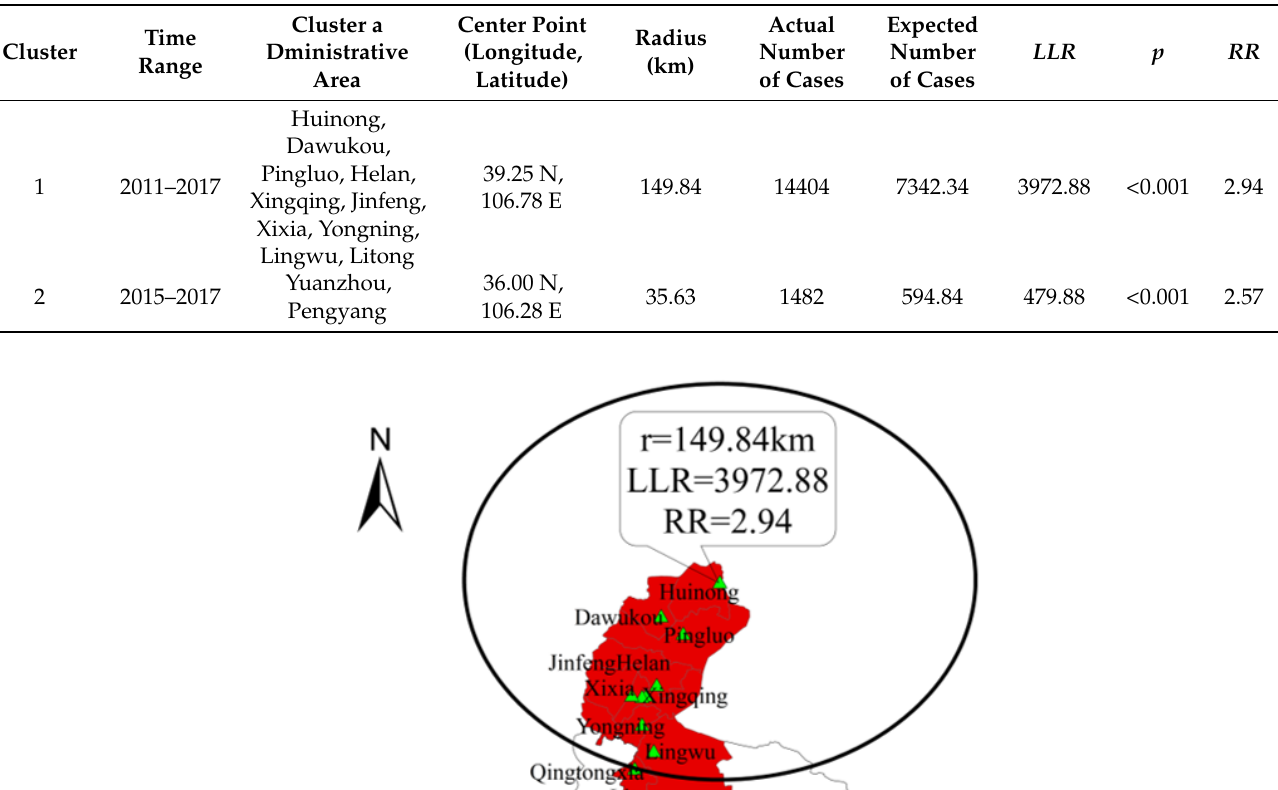
Table 1. Results of spatiotemporal scan of syphilis incidence in Ningxia from 2004 to 2017.